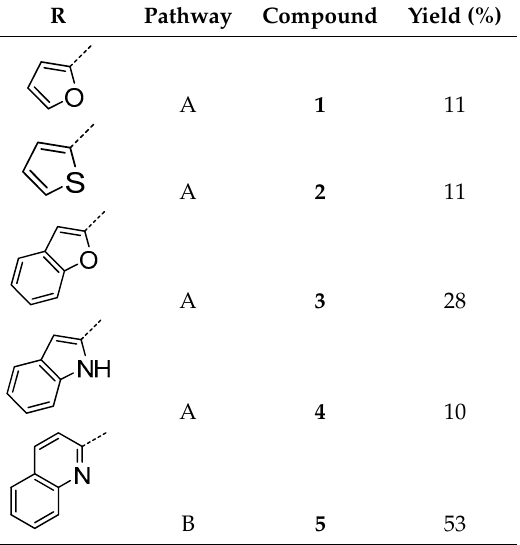
Table 1. Penta-heterocyclic compounds.